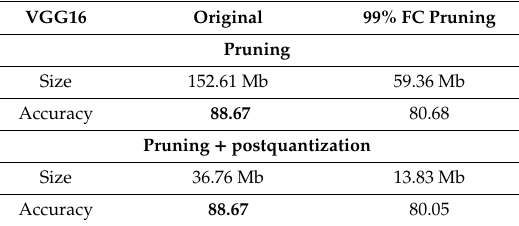
Table 6. Comparison in terms of size and accuracy before and after compression of the VGGNet FC-layer on the plant seedlings database.